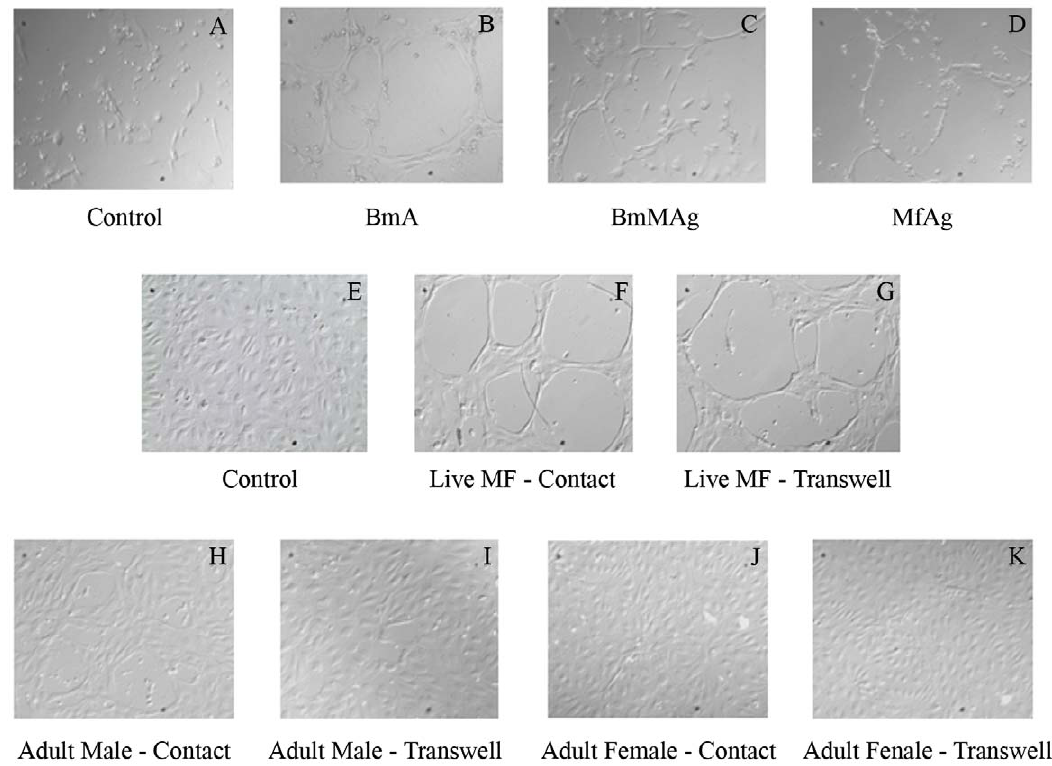
Figure 3. Microscopic images of filaria-induced lymphatic tube-like structure formation. LEC were seeded in endothelial basal media (Panels A and E) and stimulated with BmA (B), BmMAg (C), and MfAg (D), live microfilariae (F), live adult males (H), adult females (J) in contact or in transwells with live microfilariae (G), adult males (I), or adult females (K). (Magnification 20 6 (Panels A–D), 40 6 (Panels E–K)).